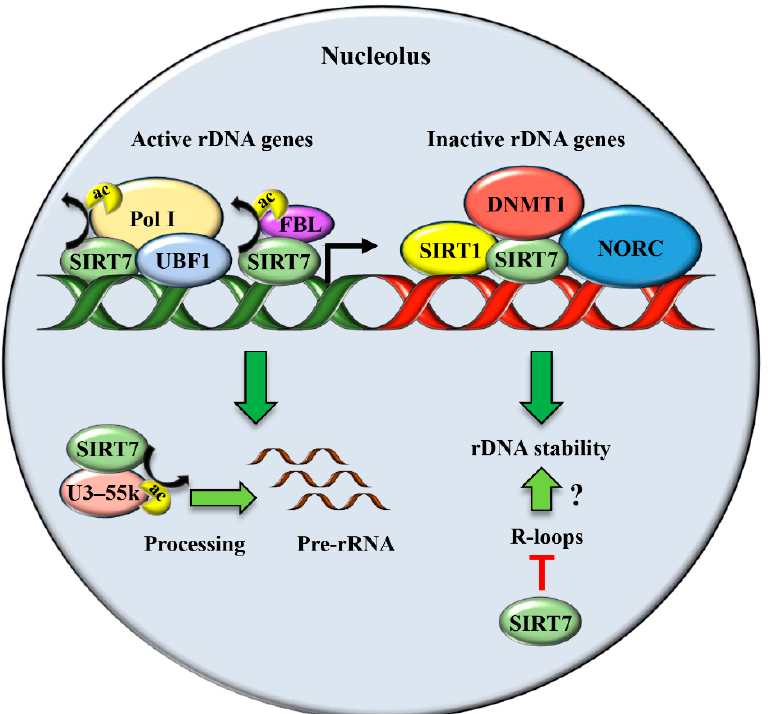
Figure 2. SIRT7 has a dual function in the unstressed nucleolus. SIRT7 stimulates rDNA transcription by facilitating recruitment of Pol I both by interacting with UBF1 and through direct deacetylation of the Pol I subunit PAF53. In addition, SIRT7 deacetylates fibrillarin (FBL) and thereby favors FBL-mediated chromatin remodeling required for stimulation of rDNA transcription. SIRT7 also promotes pre-rRNA processing by deacetylating U3–55k, a core component of the U3 snoRNP complex. SIRT7 is a key player for maintaining rDNA stability at inactive rDNA genes by promoting heterochromatin formation through recruitment of SIRT1 , DNMT1, and the chromatin remodeling complex (NORC). Moreover, SIRT7 might maintain rDNA stability by facilitating resolution of